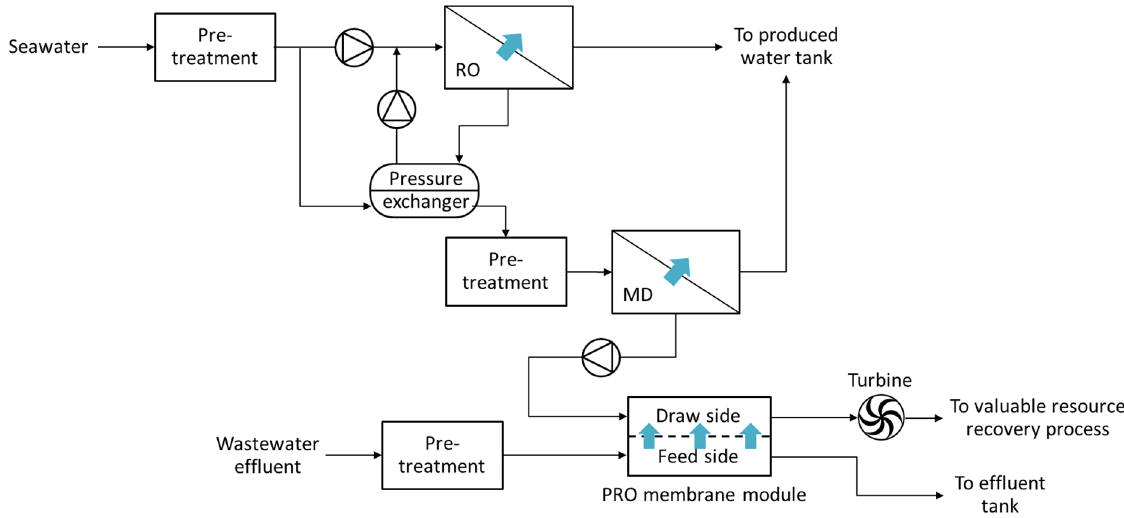
Figure 6. Schematic of the RO-MD-PRO hybrid plant in Korea, adapted from